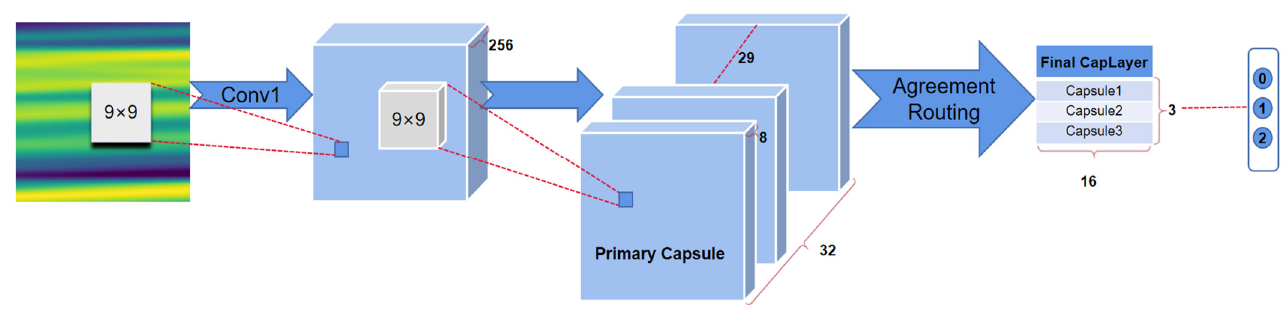
Figure 3. Schematic of the CapsLayer model.